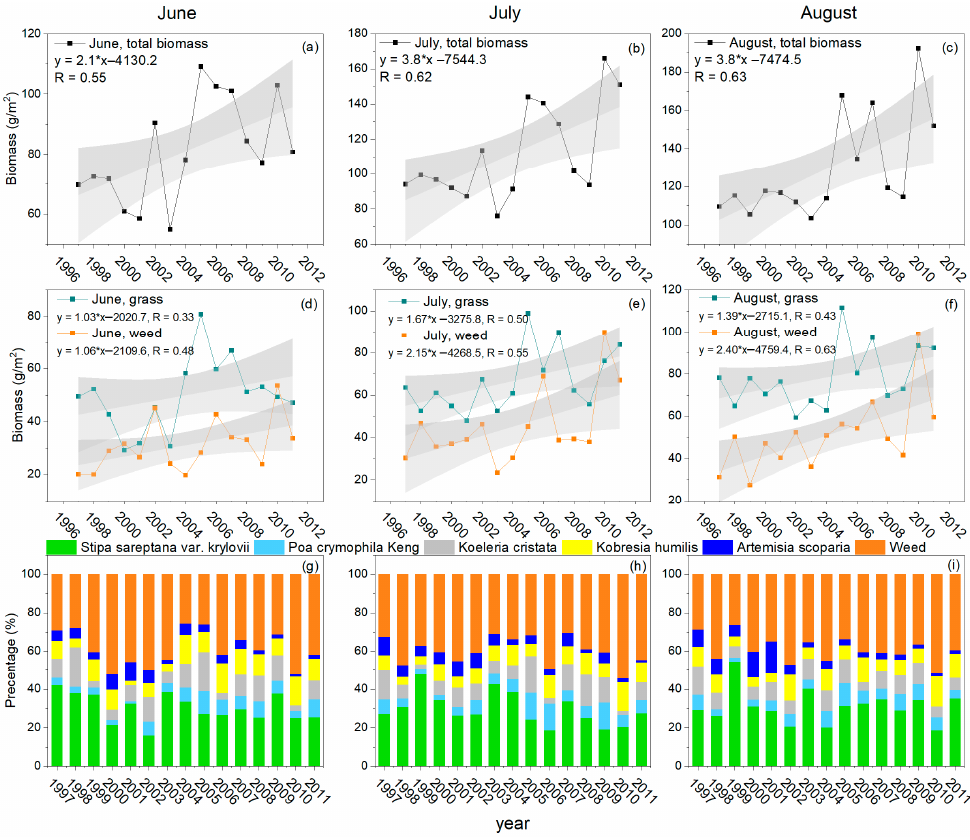
Figure 2. Variations of AGB in June, July, and August during 1997~2011, ( a – c ): total biomass; ( d – f ): grass and weed; ( g – i ): percentage of different species. Trends estimated by the least-squares linear regression are shown in the graphs.